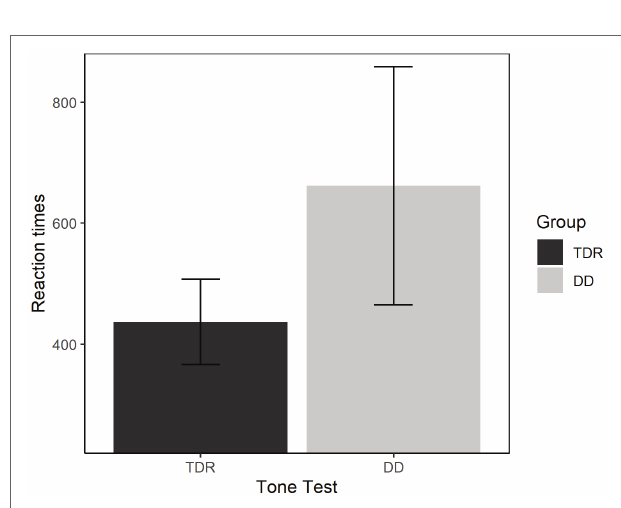
FIGURE 9 | Reaction times in auditory tasks. Error bars represent standard errors. TDR, typically developing readers, DD, developmental dyslexics.